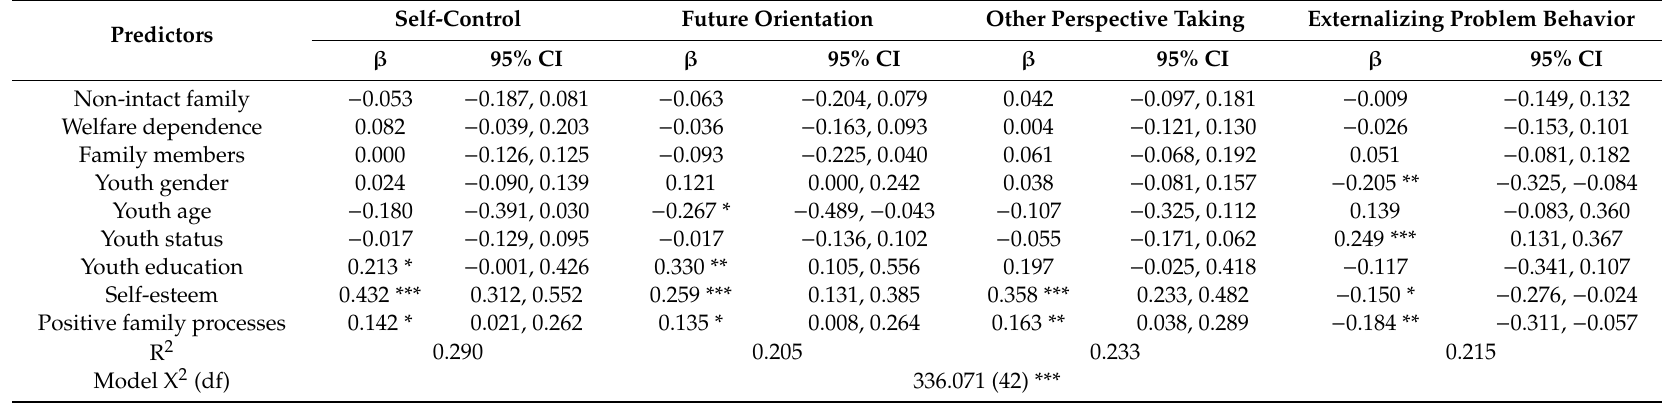
Table 6. Multivariate linear regression modeling predicting self-control, future orientation, other perspective taking and externalizing problem behaviors of youth by their self-concept and positive family